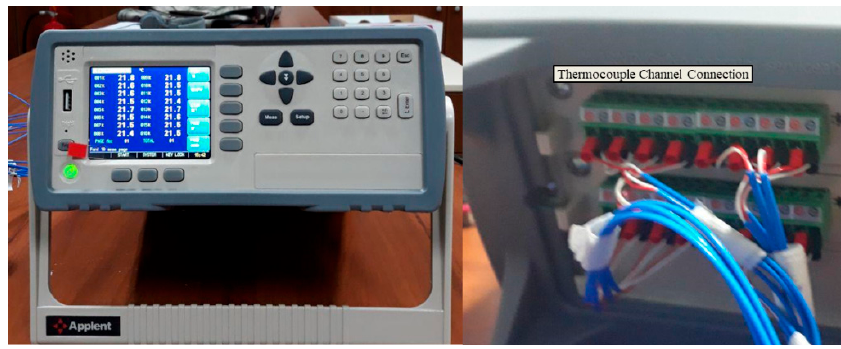
Figure 7. Temperature data acquisition device (T-DAQ).